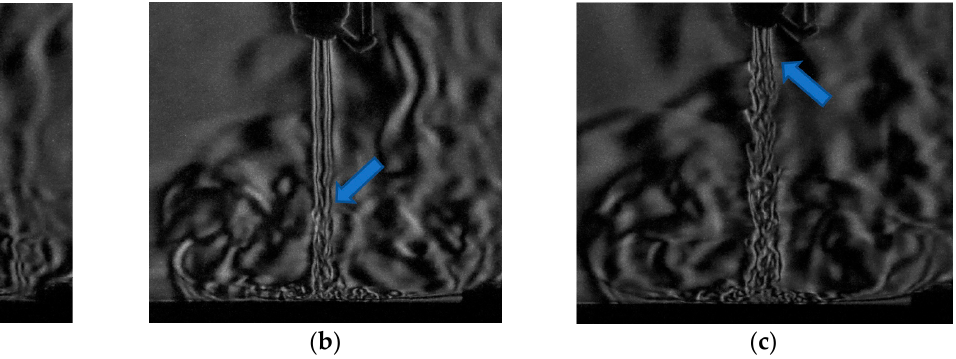
Figure 3. The flow of Freon-22 jet on the obstacle, isothermal flow, d = 3 mm, flow from top to bottom. Camera Canon EOS 6500, ISO 12800, 1/4000 s. Gilbert diagnostics. ( a )—unperturbed laminar impinging jet; ( b , c )—the flow of a puff-type vortex structure on the obstacle.